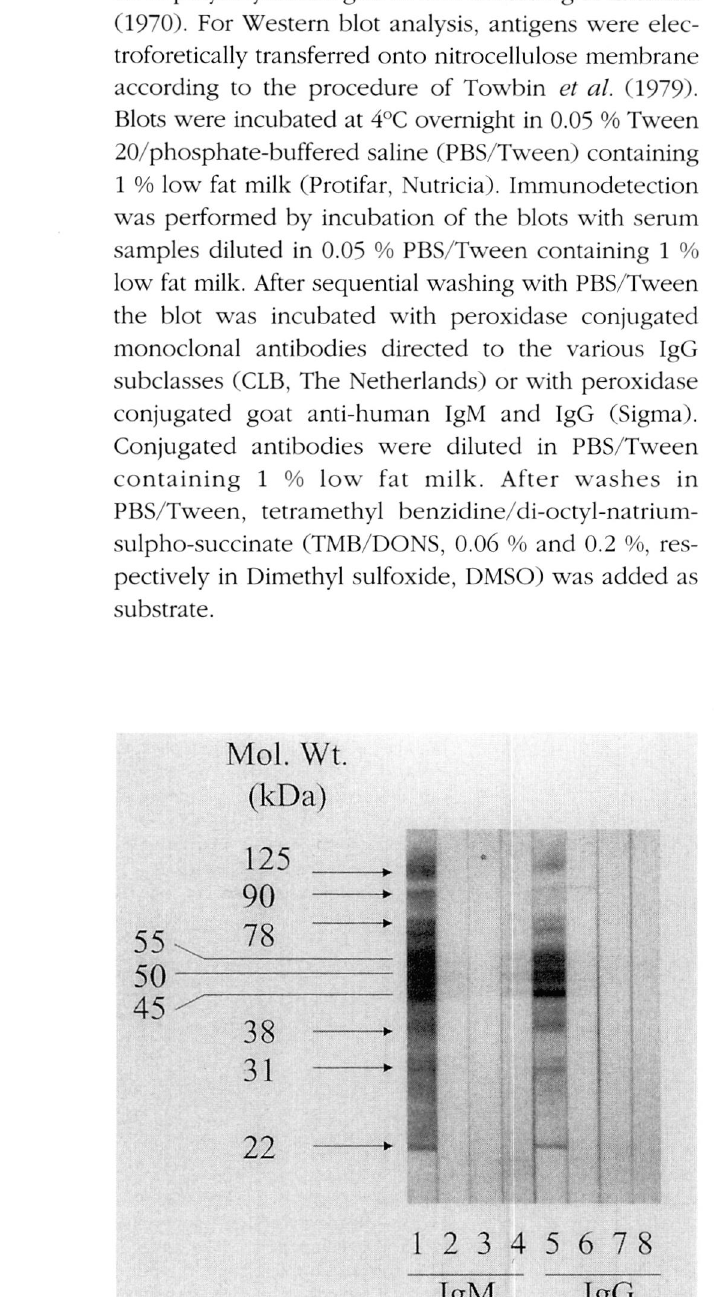
FIG 1. - Western blot revealing bands recognized by Trichinella-spu- cific IgM and IgG antibodies. The ES antigen electrephorized on 10